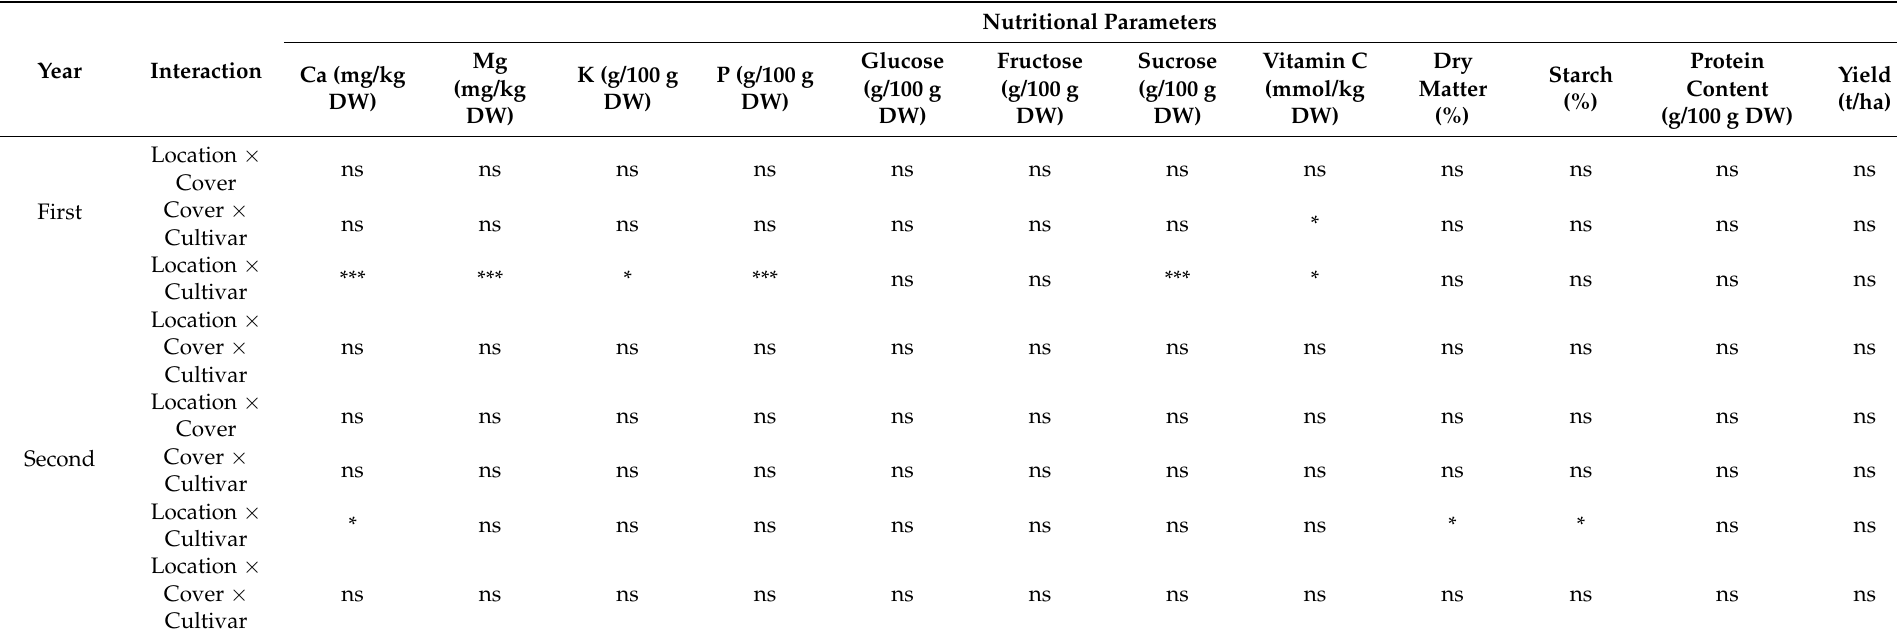
Table 3. Interaction between location, plant cover and cultivar effects on nutritional parameters in the first and second harvest